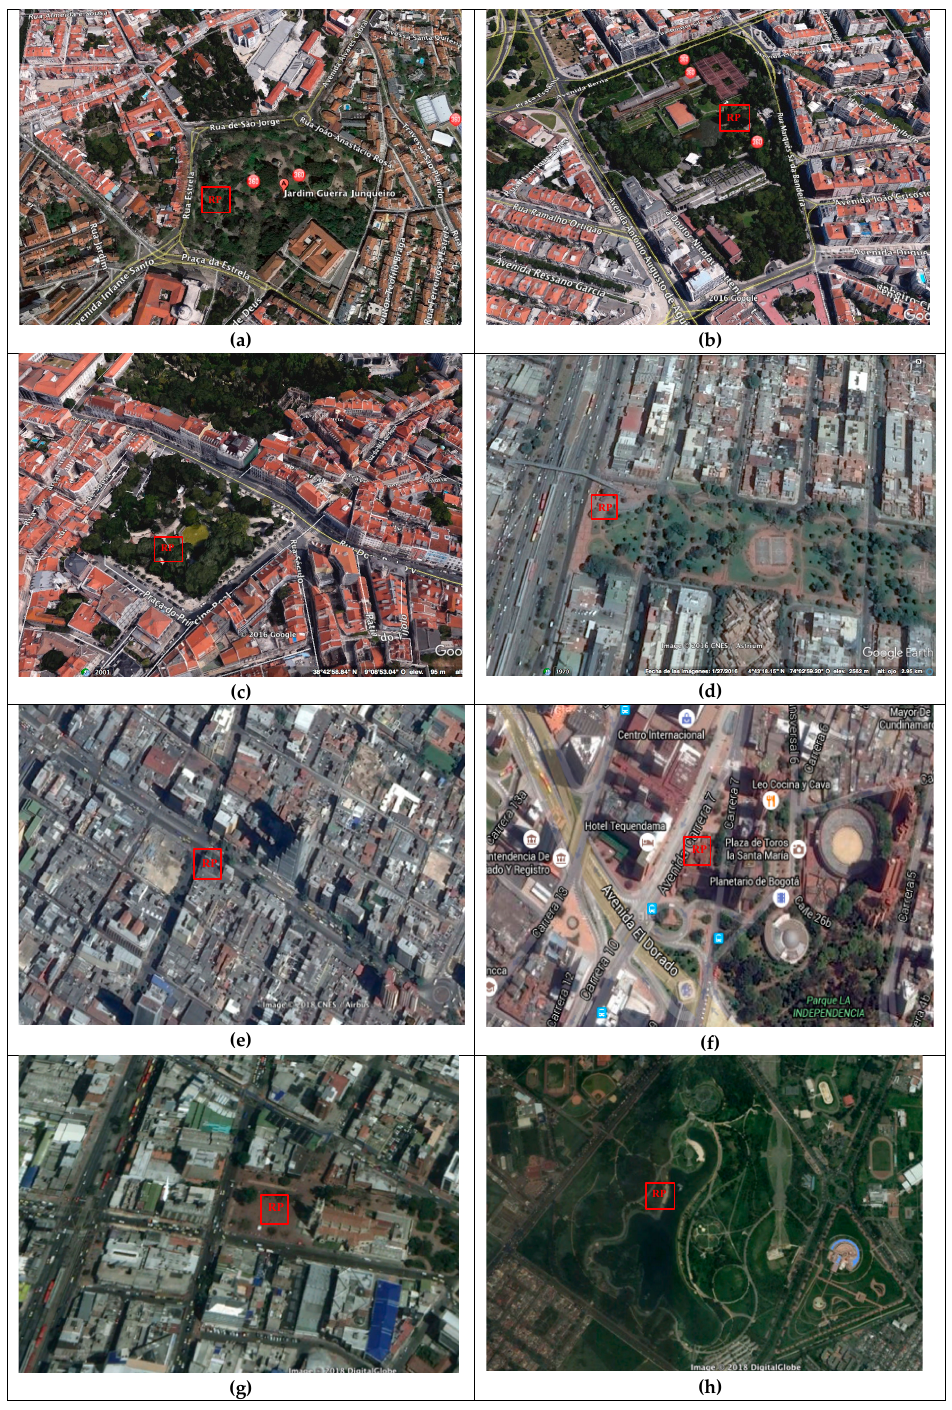
Figure 1. Urban Spaces in Lisbon and Bogotá cities. ( a ) Jardim da Estrela (LJES); ( b ) Jardim da Fundação Calouste Gulbenkian (LJFG); ( c ) Jardim do Príncipe Real (LJPR); ( d ) Autopista norte estación Alcalá (BOAPA); ( e ) Calle 19 con Cra. 7 (BOC197); ( f ) Fuente de agua edificio Tequendama (BOFAET); ( g ) Plaza de Lourdes (BOPL); ( h ) Simón Bolívar park (BOPSB).